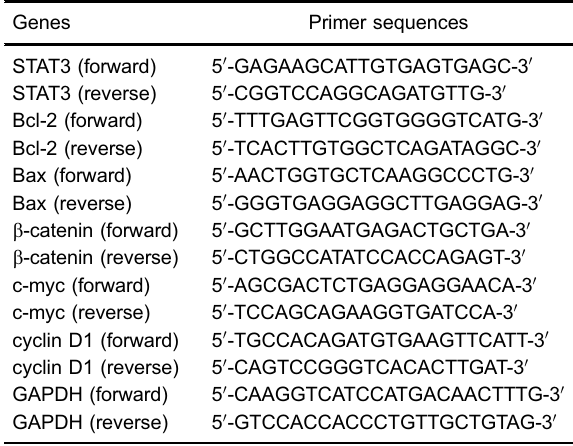
Table 1. Primer sequences for